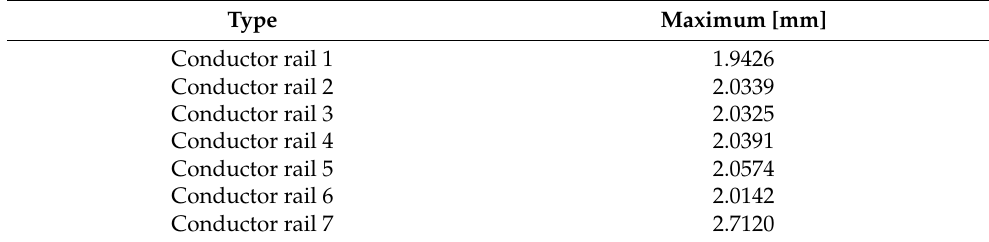
Table 2. Maximum sag of the multi-span conductor rail.